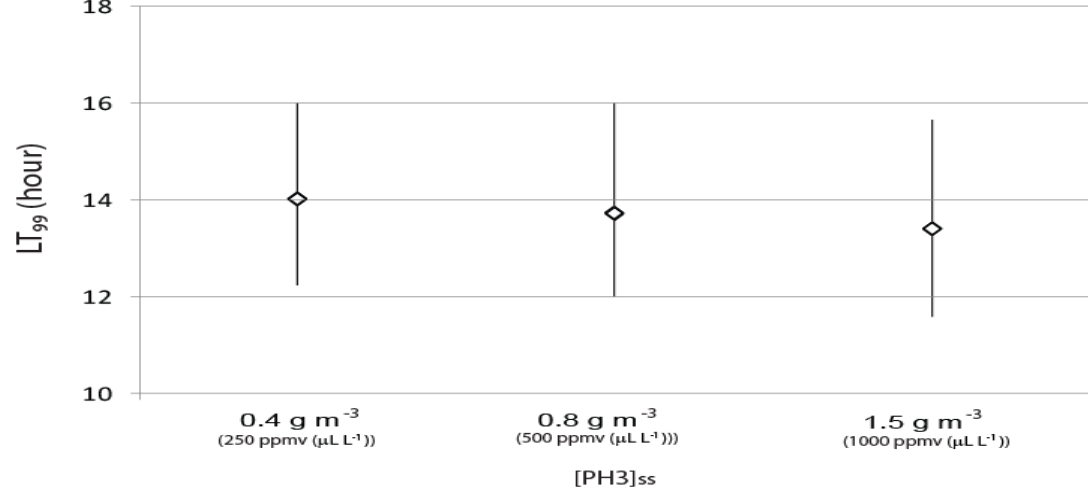
Figure 3. The projected durations to cause 99% mortality in the treated population (LT 99 ) of bean thrips (BT) adults did not vary as a function of steady-state headspace concentrations, [PH 3 ] ss , over the range 0.4 to 1.5 g m −3 (250 to 1000 ppmv (µL L −1 )), indicating that variability in phosphine levels within that range will not change the efficacy of fumigation. Error bars are the estimates of the bounds (upper (UL) and lower (LL) limits) at the 95% confidence level (CL) (see Figure 1). These results indicate that the narcosis threshold for adult BT at air temperature 4.9 ± 0.3 ◦ C ( x ± 2 s ) spans [PH 3 ] ≥ 0.4 and ≤1.5 g m −3 (250≥ and ≤1000 ppmv (µL L −1 )). If headspace concentrations of phosphine, [PH 3 ], are recorded outside this “optimal” range, a longer treatment duration could potentially be required to achieve 99% mortality.